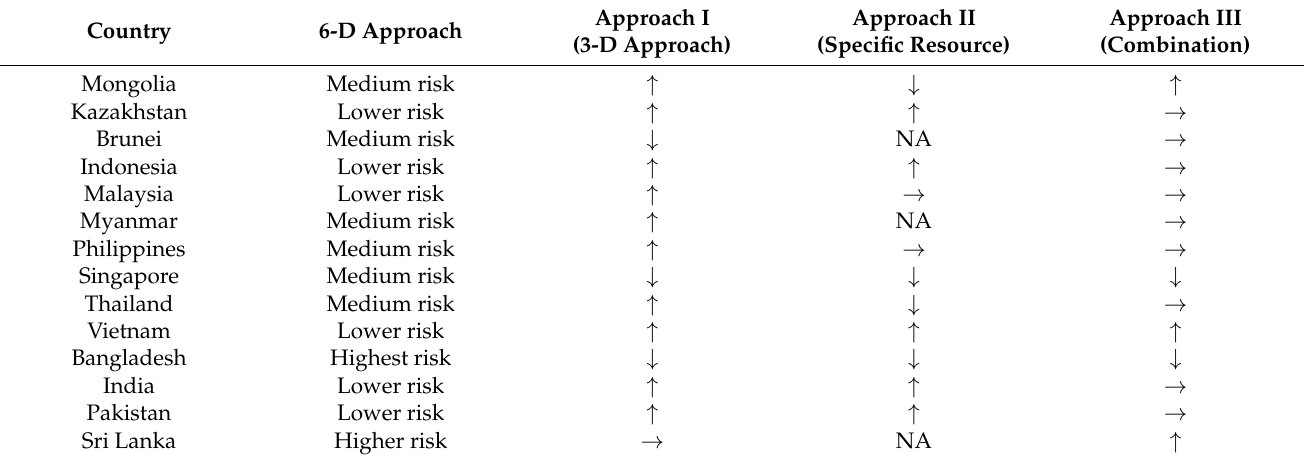
Table 6. Comparison of risk assessment results in Central Asia and Southeast Asia.